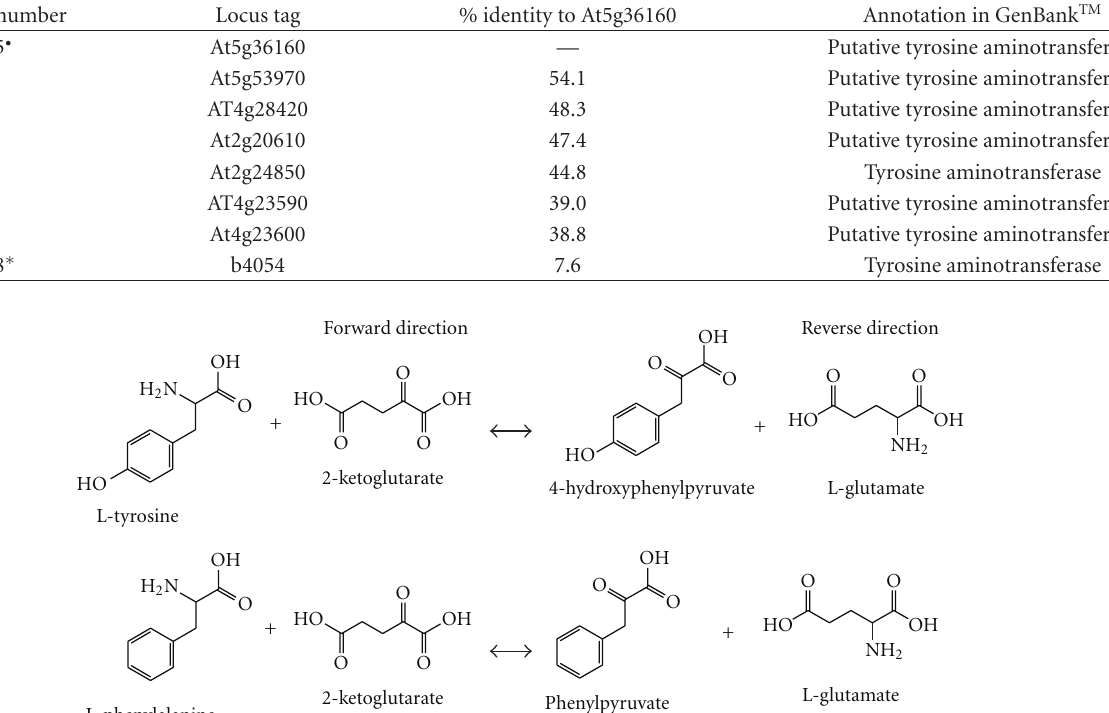
aminotransferase), tyrB (L-Tyrosine